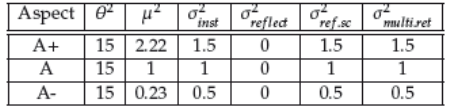
Table 1. Values required for initializing the validation processing.